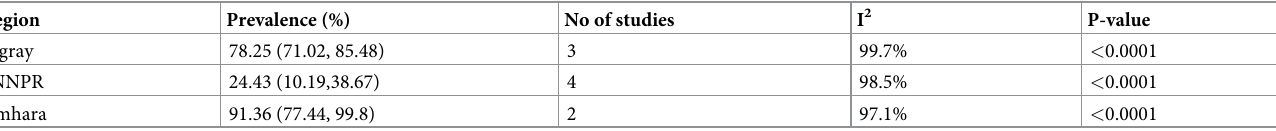
Table 3. Subgroup analysis of perinatal death of uterine rupture by region.